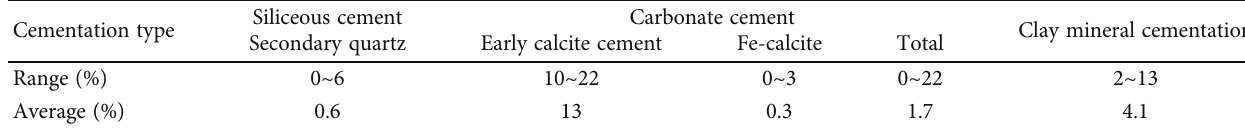
Table 1: Absolute content of